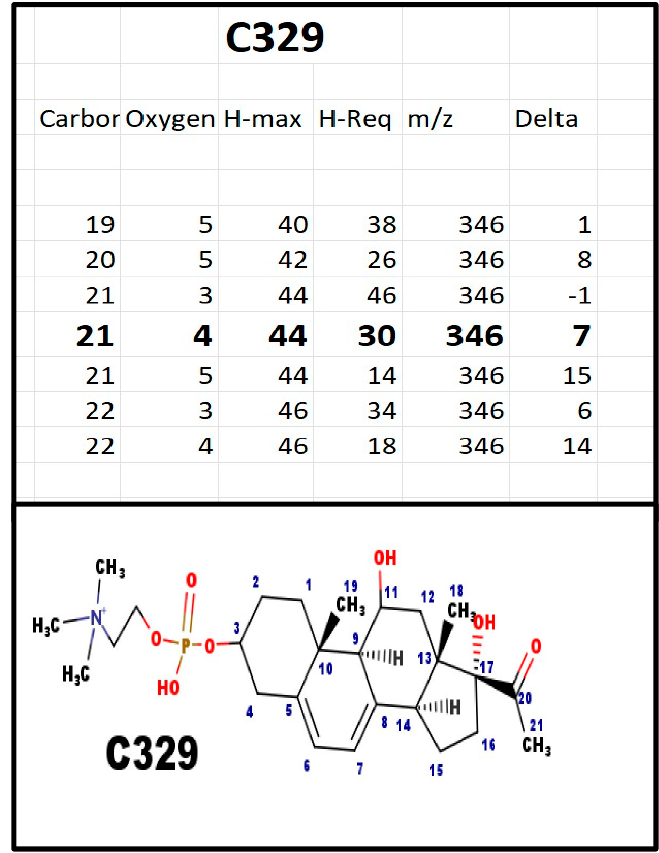
Figure A2. The proposed structures of C329.